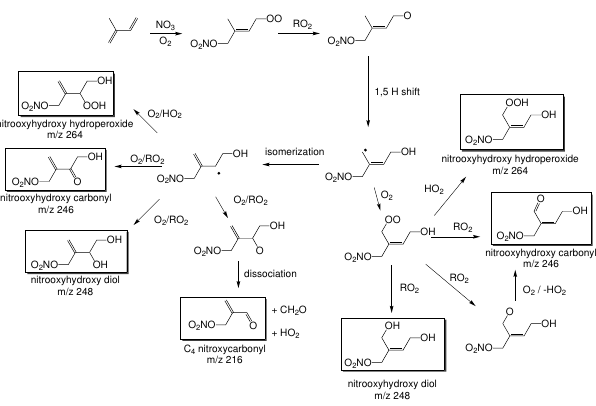
Fig. 2. Formation mechanism of compounds resulting from the Fig.2. Formationmechanismofcompoundsresultingfromtheisomerizationofalkoxyradicalsandmeasured by the CIMS at m/z 216, 246, 248, and 264. This figure assumes initial NO 3 attachment to the 1-carbon and isomerization of alkoxy radicals and measured by the CIMS at formationofan(E)- δ -peroxyradical,butotherisomersarepossible. m/z 216, 246, 248, and 264. This figure assumes initial NO 3 at- tachment to the 1-carbon and formation of an (E)- δ -peroxy radical, but other isomers are